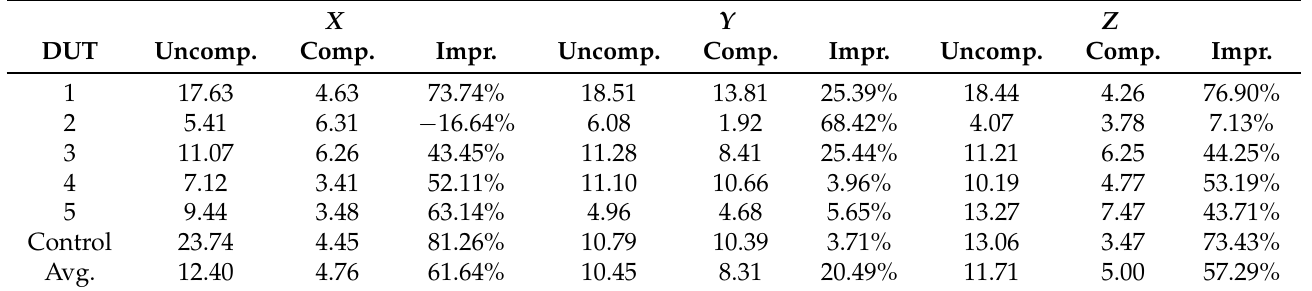
Table 7. Maximum deviation of the DUTs during the verification test